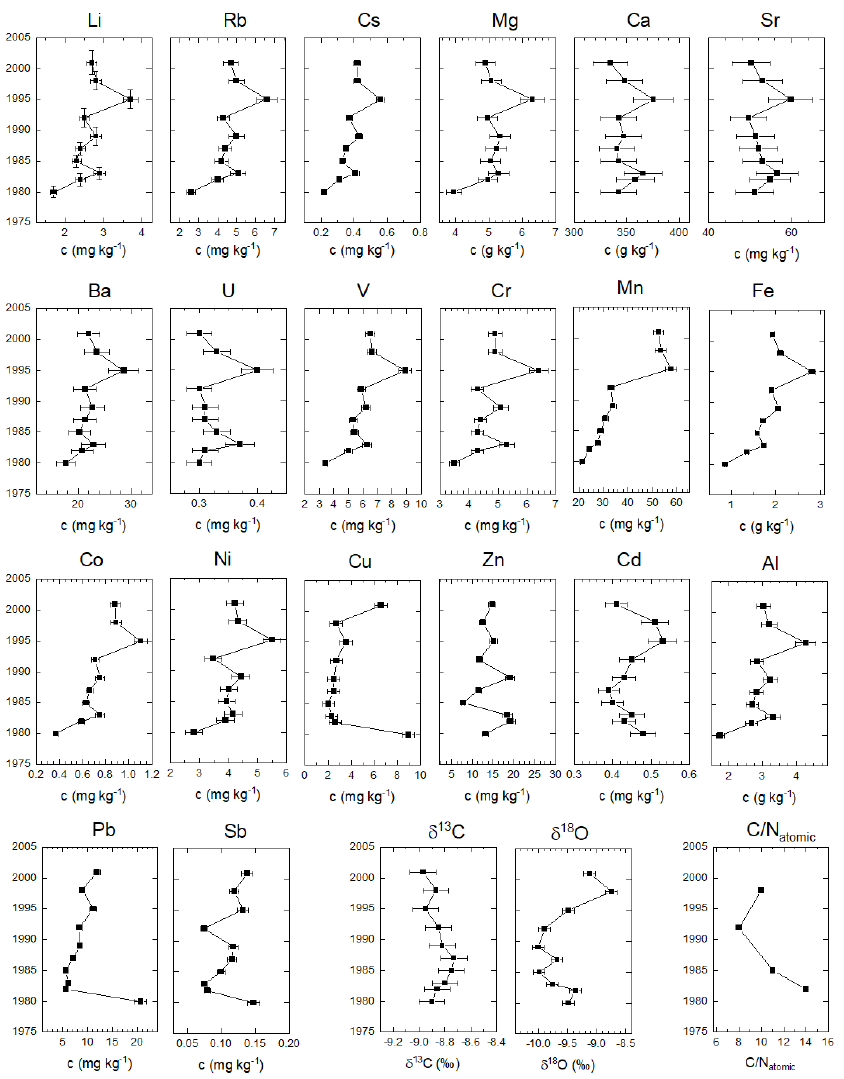
Figure 3. Mass concentrations of analyzed metals in tufa, δ 13 C and δ 18 O of tufa carbonate, and C/N ratio of organic part in tufa from the Korana River, presented in chronological order of layer depo- sition.